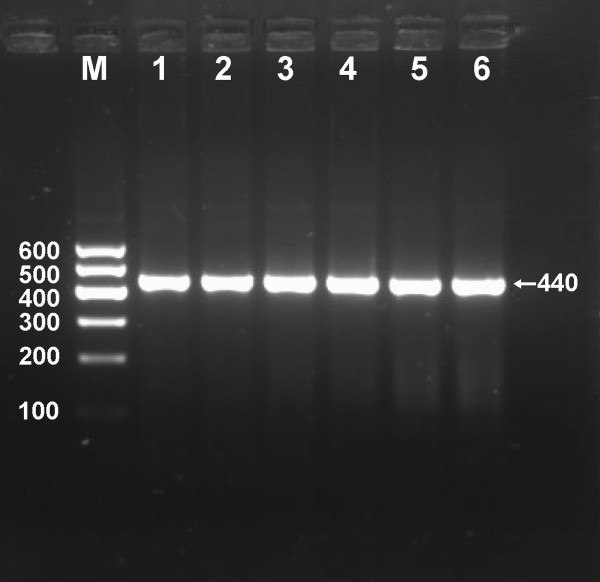
Electrophoresis of PCR products of the samples. Lane M, 100 bp marker ladder; lanes 1-6, samples. The 440 bp bands are the target genes.